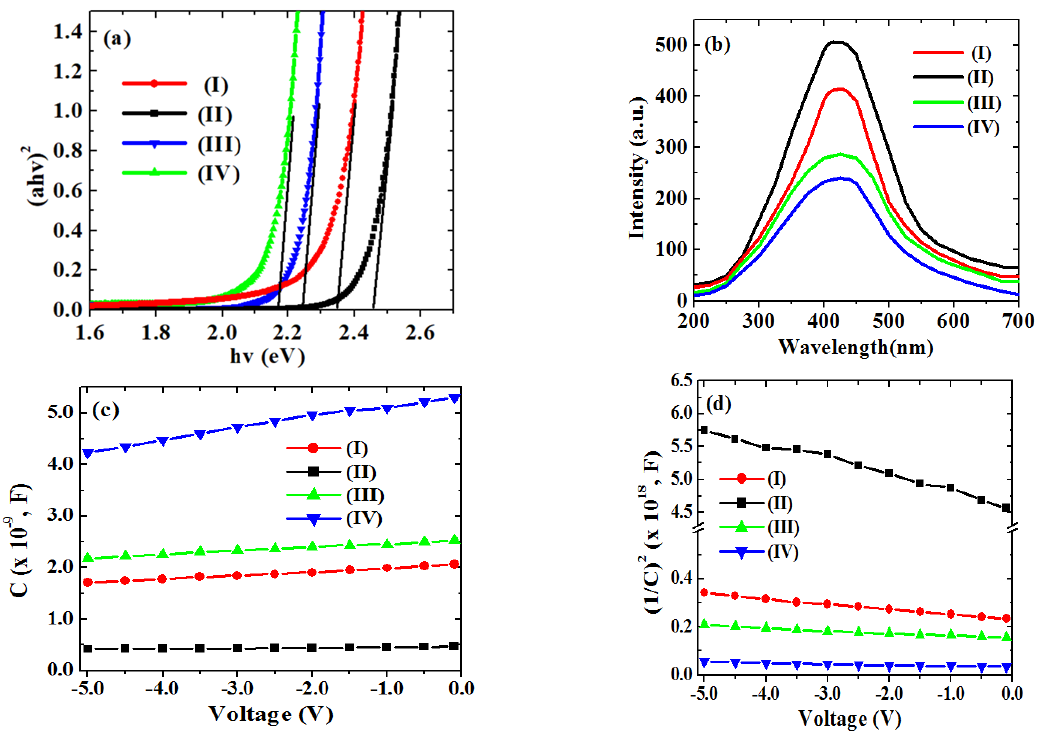
Figure 7. ( a ) Tauc plot and ( b ) photoluminescence spectra, ( c ) capacitance – voltage diagram and ( d ) (1/Capacitance) 2 versus reverse-bias voltage of (I) SrFe 2 O 4 , (II) TiFe 2 O 5 , (III) Sr 0.7 Ti 0.3 Fe 2 O 4.3 and (IV) Sr 0.4 Ti 0.6 Fe 2 O 4.6 NPs.